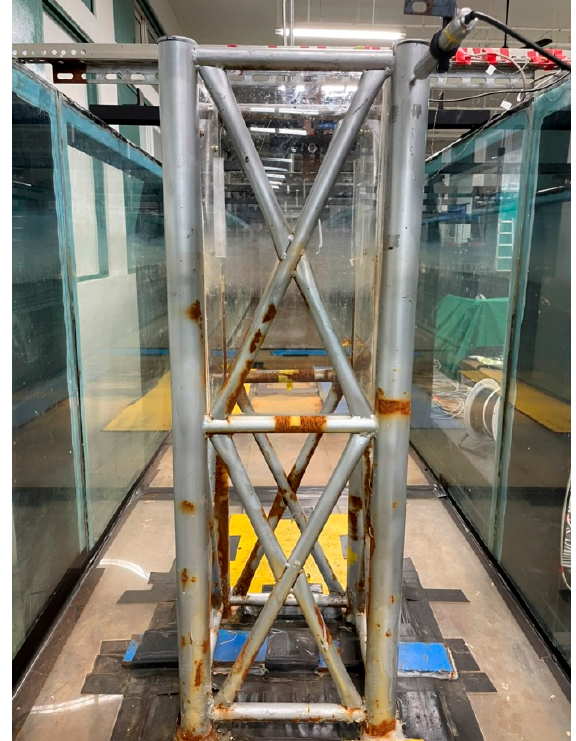
Figure 5. The testing model installed with the measuring system in the water tank. Table 1. Scaled parameters for the model relative to the prototype